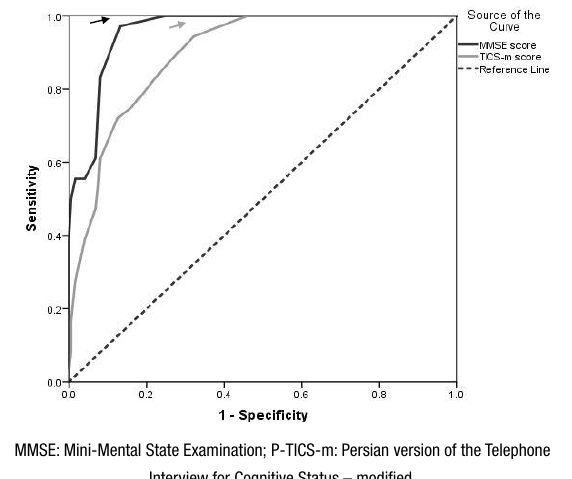
Figure 1. Receiver operating characteristics of the TICS-m and MMSE instruments.